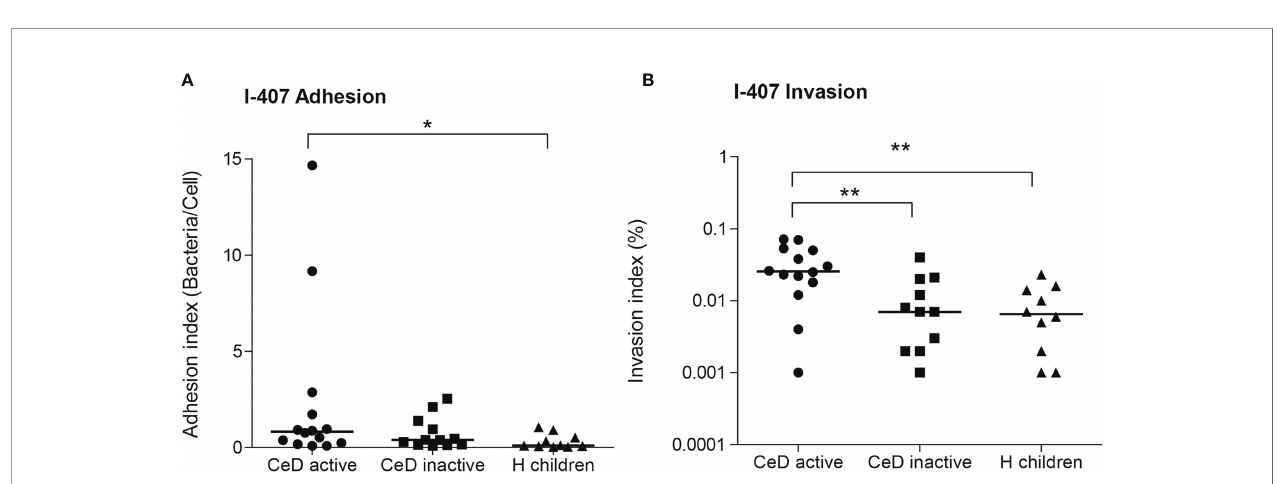
FIGURE 4 | Adhesion (A) and invasion (B) indices of E . coli isolates from patients with active and inactive celiac disease (CeD) and healthy (H) children (median indicated). Only non-AIEC strains included (N = 14 active CeD; N = 12 inactive CeD; N = 10 H children). *p ≤ 0.05; **p ≤